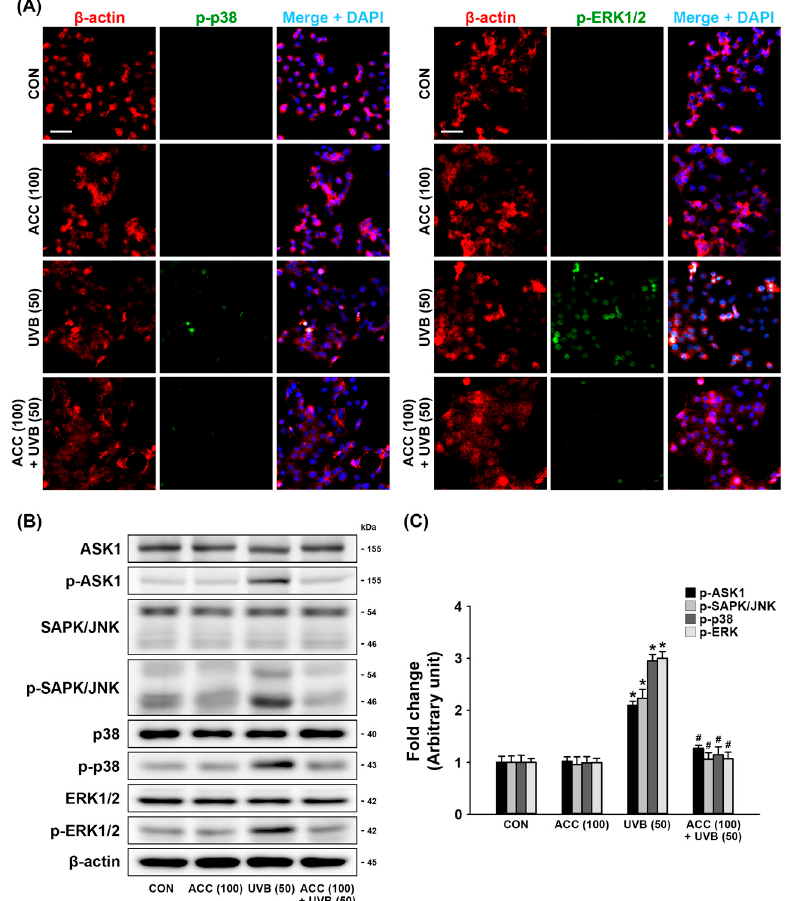
Figure 6. E ff ect of ACC treatment on mitogen-activated protein kinase (MAPK) expression in Figure 6. Effect of ACC treatment on mitogen-activated protein kinase (MAPK) expression in UVB- UVB-irradiated HaCaT cells. irradiated HaCaT cells. ( A ) Representative images of immunofluorescence labeling for β -actin (red) and phospho-p38 (p-p38; green) or β -actin and phospho-p44/42 MAPK (p-ERK1/2; green) in UVB- Scale bar, 50 µ m. ( B , C ) E ff ects irradiated (50 mJ/cm 2 ) HaCaT cells. Scale bar, 50 µm. ( B , C ) Effects of antiapoptosis signal-regulating